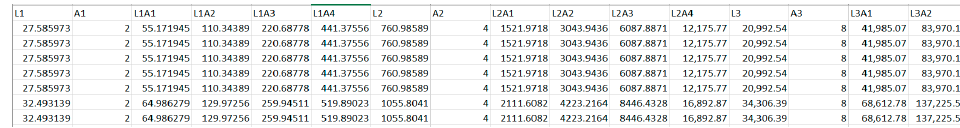
Figure 3. Result of the inverse normal transformation of the manifest data, including manifest per- centiles and norm scores ( T -scores) as well as group-specific descriptive data. The column